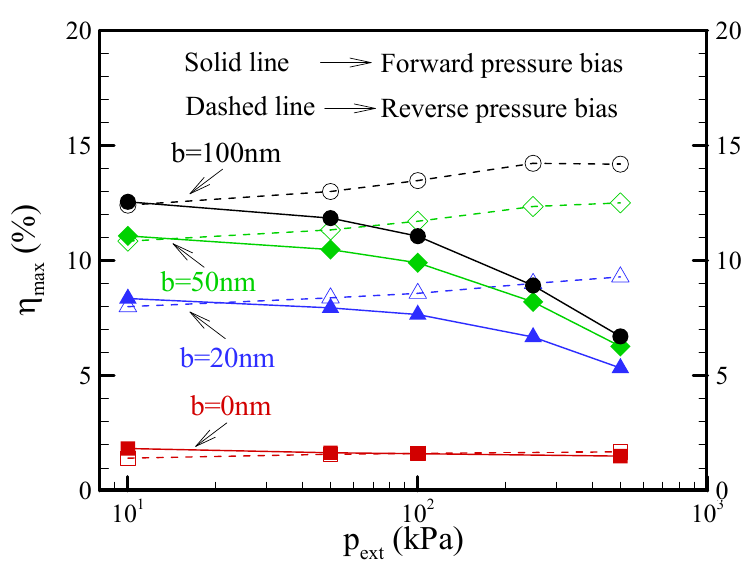
Figure 12. Plot of the maximum conversion efficiency (η max ) as a function of the pressure bias for EKEC in a conical nanopore with different slip lengths of b = 0, 20, 50, and 100 nm at a salt concentration of c 0 = 0.1 mM. Note that θ = 1.2 ◦ and σ s = − 5 mC/m 2 .